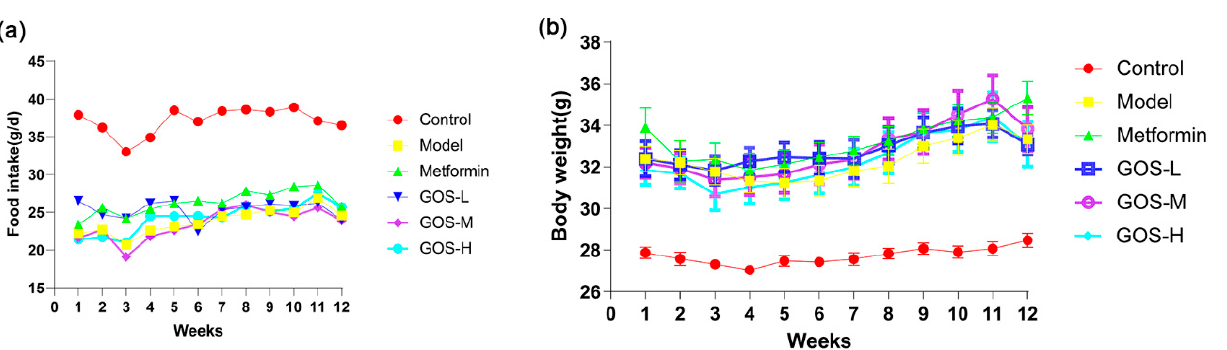
Figure 2. Average food intake of mice in each group during 12 weeks of administration ( a ) and weekly food intake of mice during the administration period ( b ), weekly body weight of mice changed after administration ( n = 10, mean ± SEM).